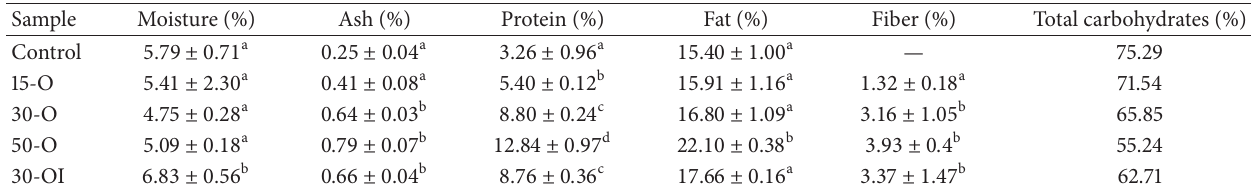
Table 1: Proximate composition of cookies.